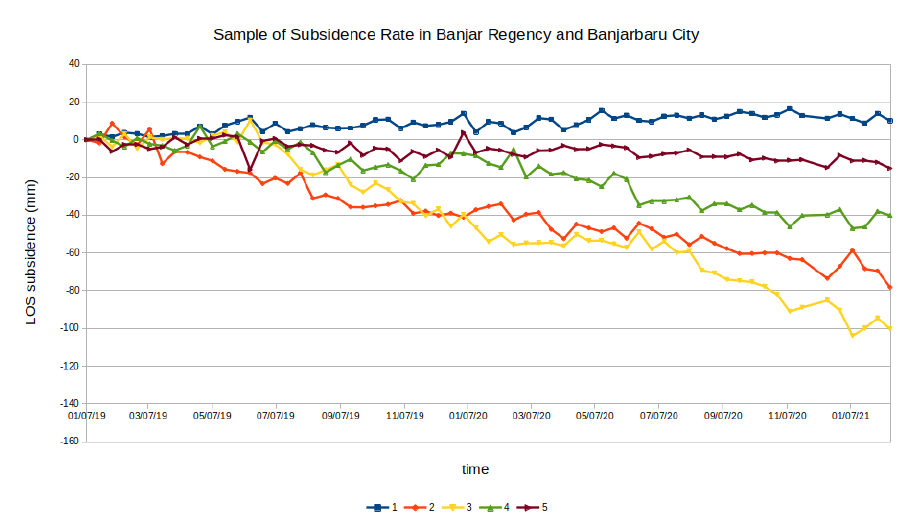
Figure 5. Sample of the time series InSAR results in Banjar Regency and Banjarbaru City, South Kalimantan, Indonesia. which is calculated by multiplying the subsidence rate by the peat bulk density and carbon